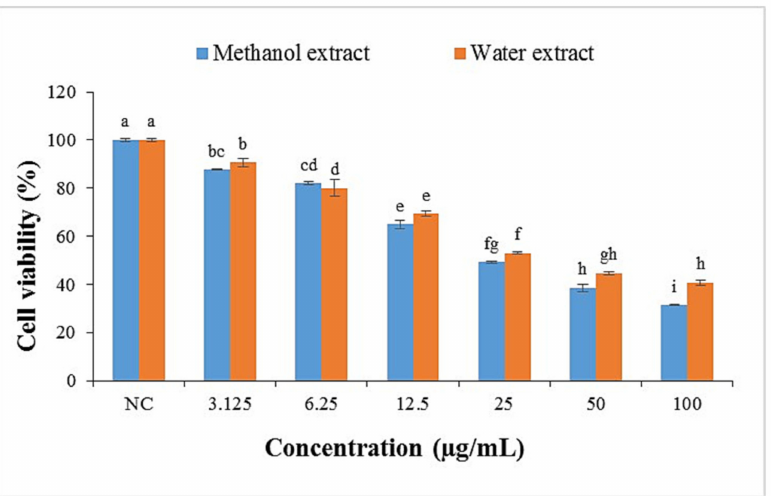
Figure 1. The cell viability (%) of 3T3-L1 preadipocyte cells measured by the MTT assay treated with methanol and water extracts of P. malayana leaves at the concentration of 3.125 to 100 µ g/mL for 24 h. Data with a different letter are significantly different with the a p -value less than 0.05. Tukey’s multiple comparison test was used to calculate the data with a 95% confidence level; n = 3. NC: Negative